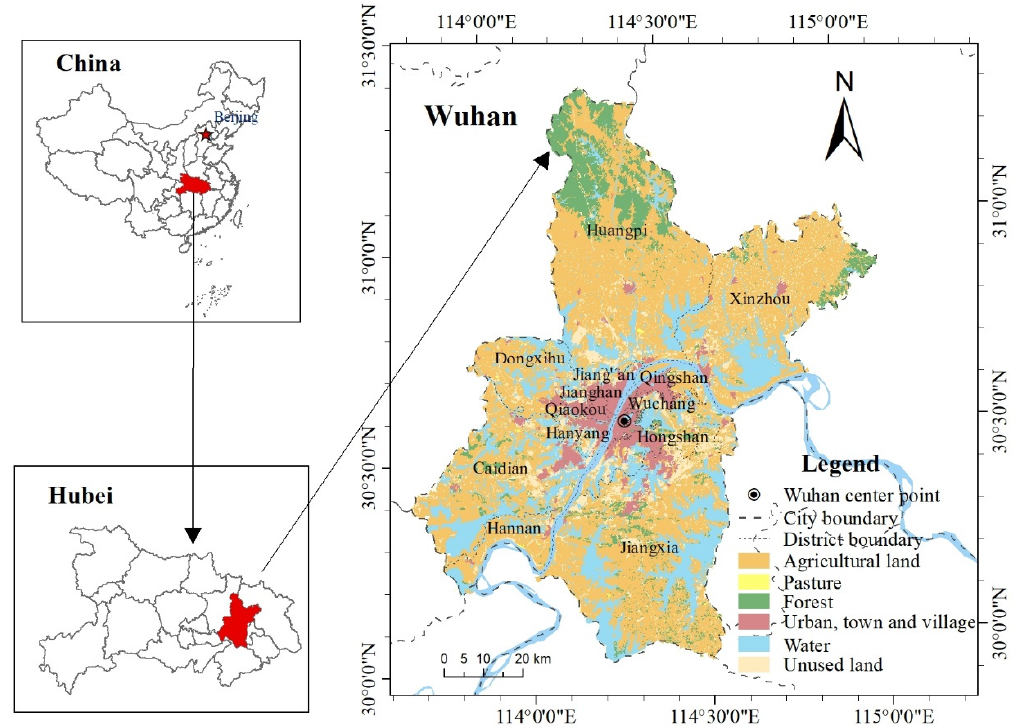
Figure 1. Location of the study area.